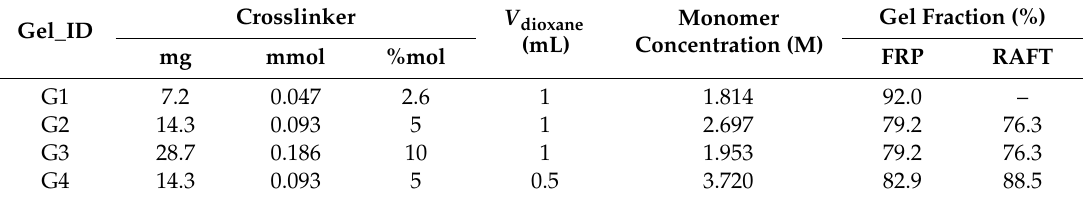
Table 1. Reaction conditions for the preparation of Poly( N -isopropylacrylamide) (PNIPAAm) gels via free radical and reversible addition-fragmentation chain transfer (RAFT)